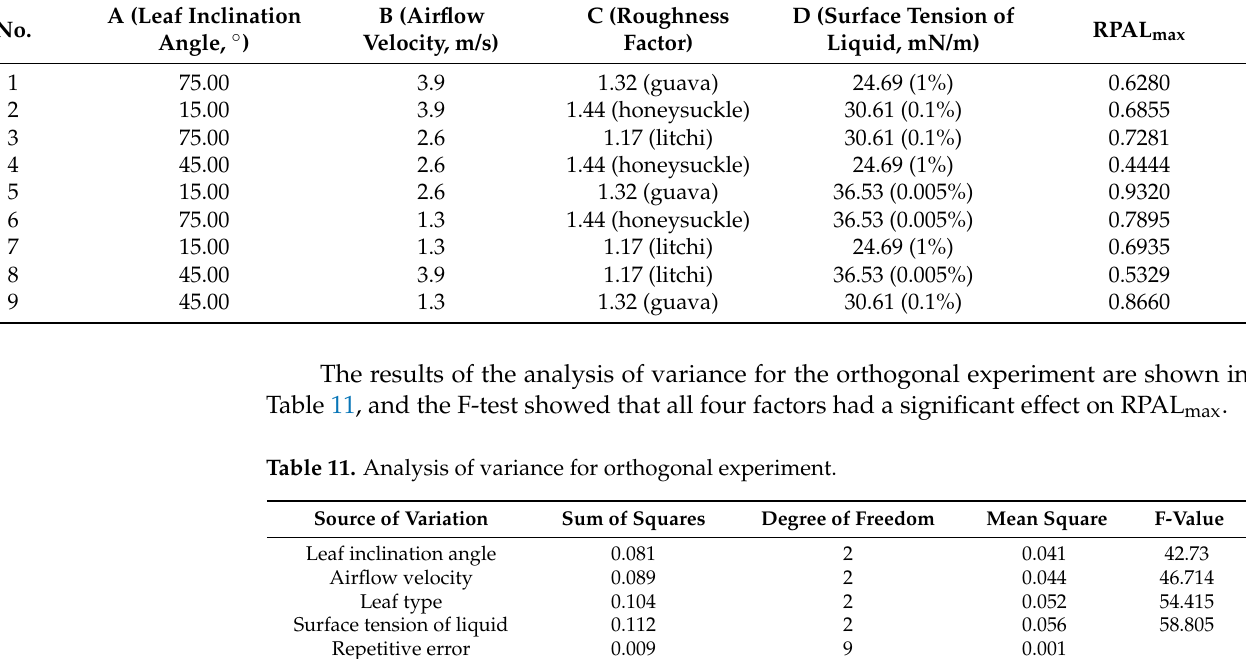
Table 11. Analysis of variance for orthogonal experiment.